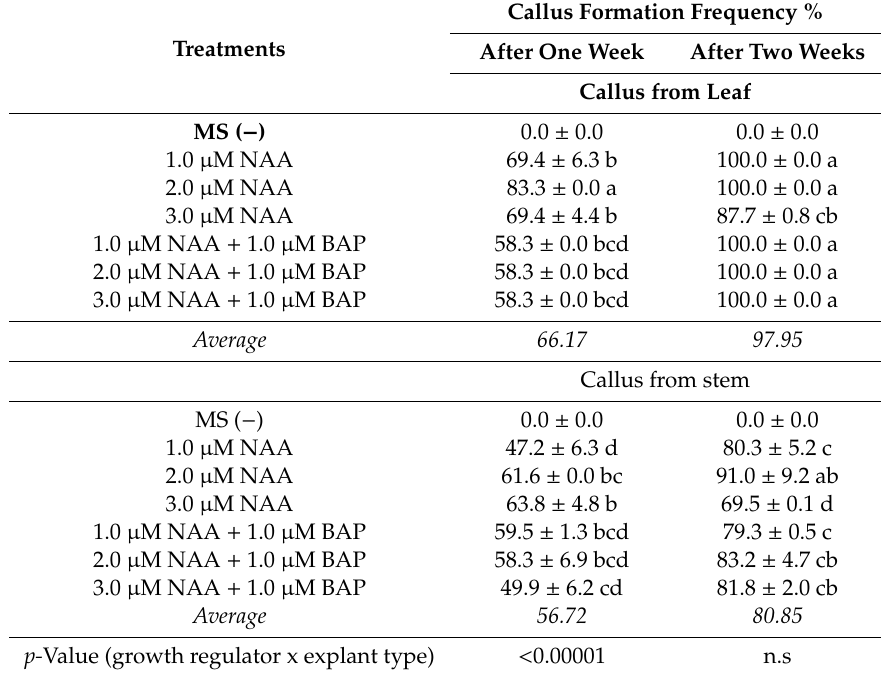
Table 1. E ff ect of growth regulators on callus formation frequency from stem and leaf explants. Mean value ± standard error, n =